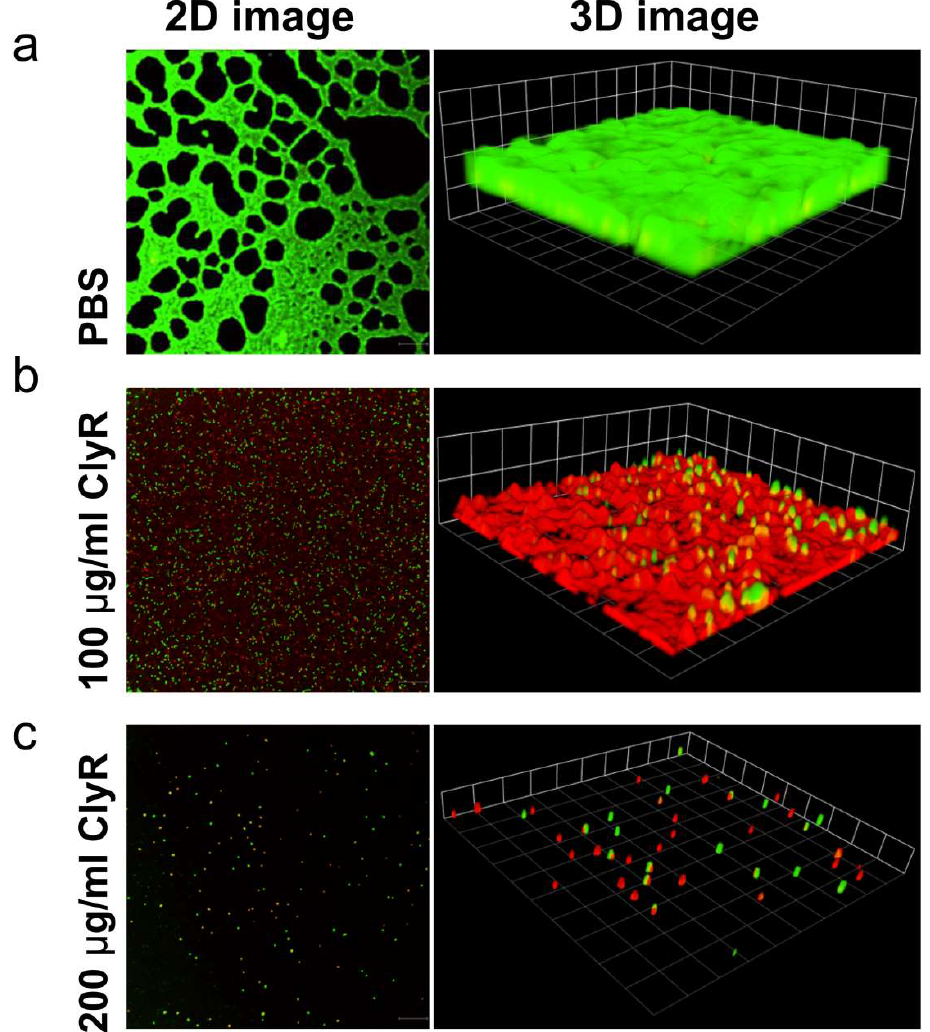
Figure 5. Confocal laser scanning microscope (CLSM) analysis of E. faecalis biofilms after exposure to 0 ( a ), 100 μ g/mL ( b ) or 200 μ g/mL ( c ) ClyR. E. faecalis ATCC 51299 biofilms grown for 24 h are treated with different concentrations of ClyR (0, 100 and 200 μg/mL) for 1 h at 37 °C. After washing with PBS, biofilms are stained with LIVE/DEAD reagent and analyzed by confocal laser scanning microscopy. Scale bars: 30 μm